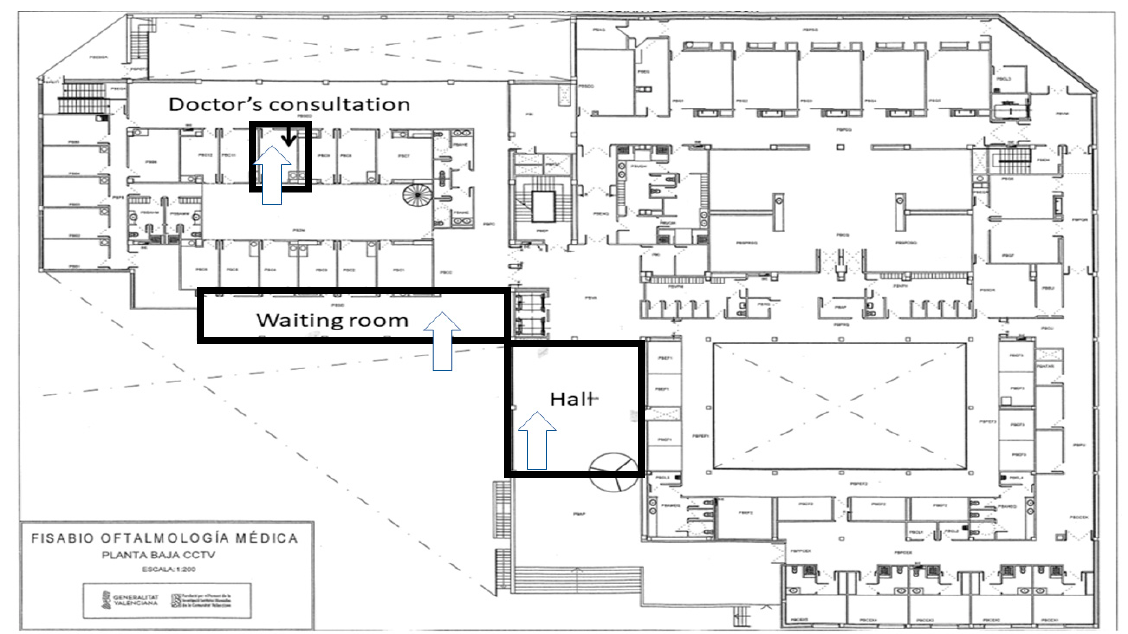
Figure 1. Map showing the sampling sites in the ophthalmological hospital: hall (2 doors, south orientation, 389.78 m 3 ), waiting room (glazed wall and closed windows, south orientation, 281.46 m 3 ), and doctor’s consultation (two doors, north orientation, 37.89 m 3 ).